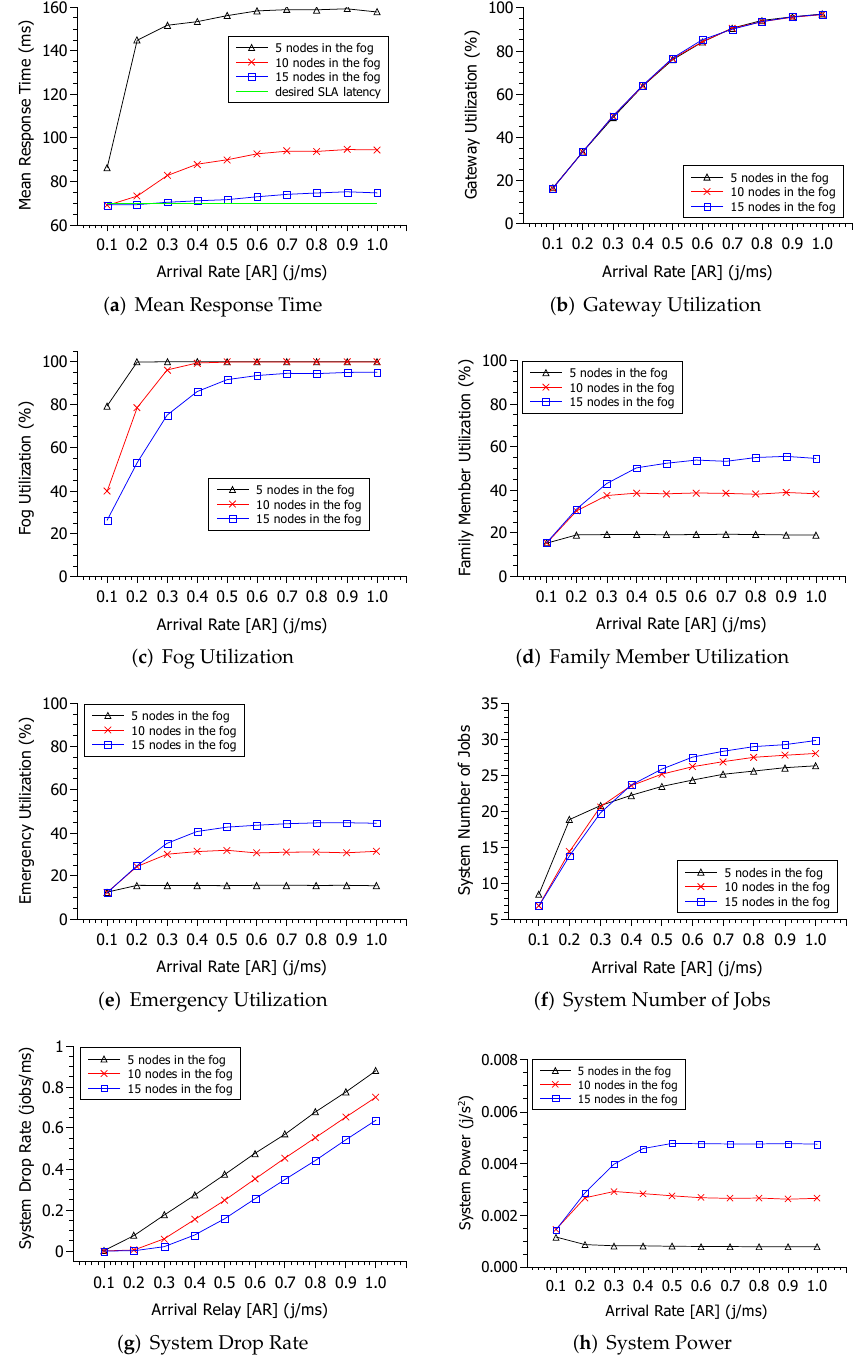
Figure 5. Results for analysis of the fog resources